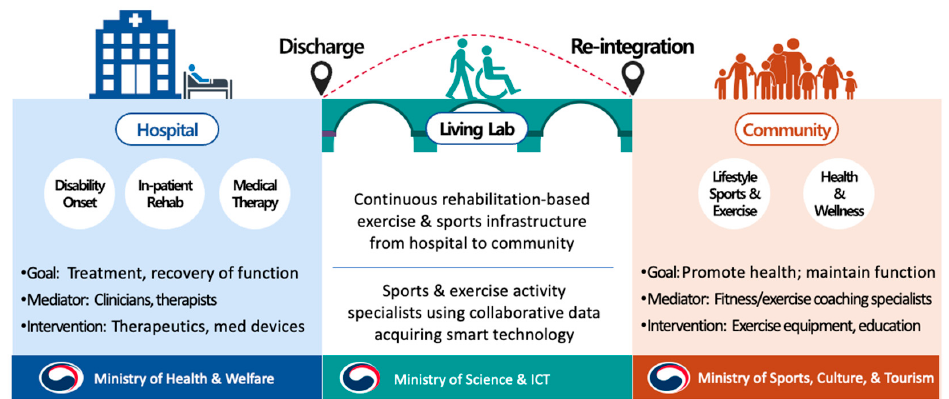
Figure 4. ‘Living Lab’ model as a testbed providing continuous rehabilitation for community-dwell- ing individuals with disabilities. individuals with